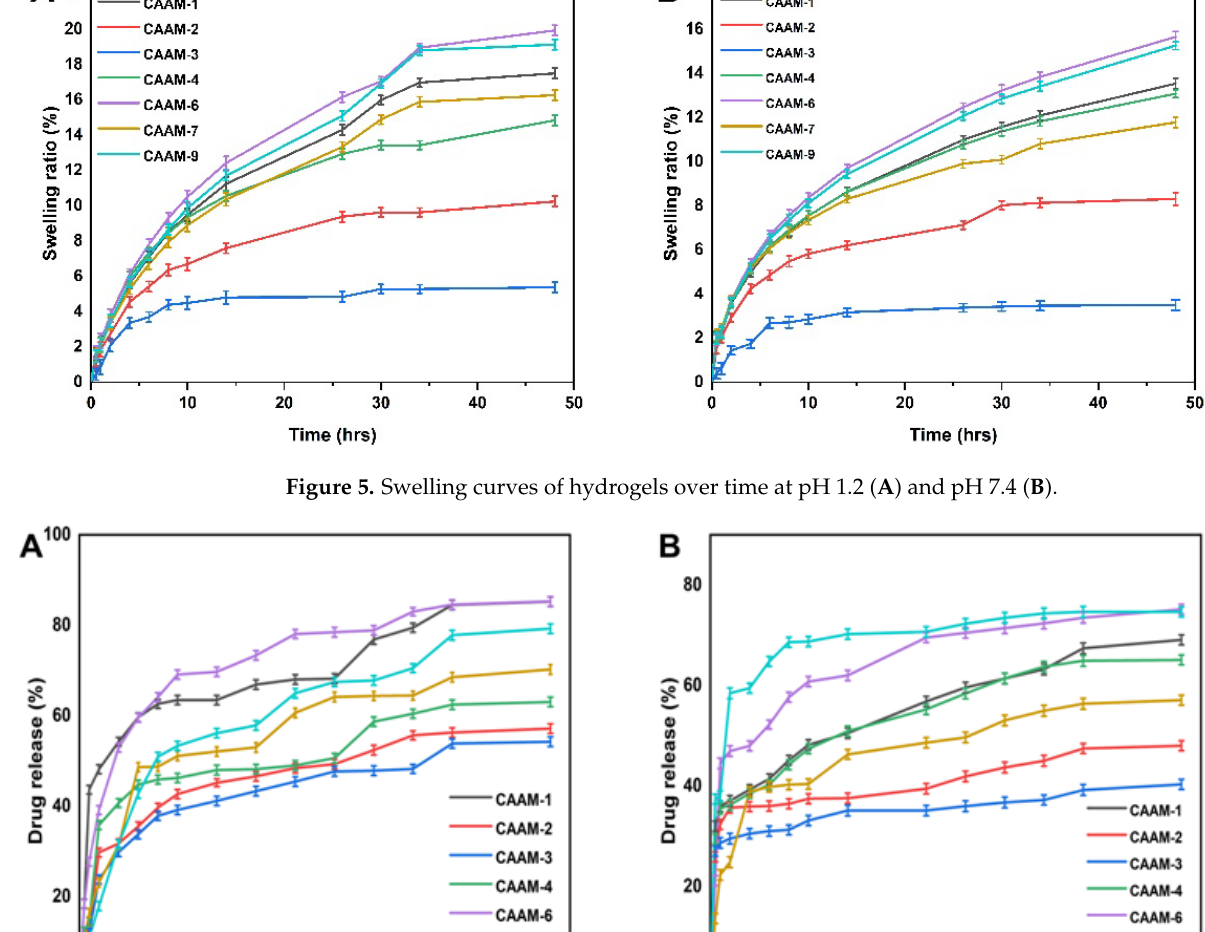
Figure 5. Swelling curves of hydrogels over time at pH 1.2 ( A ) and pH 7.4 ( B ).